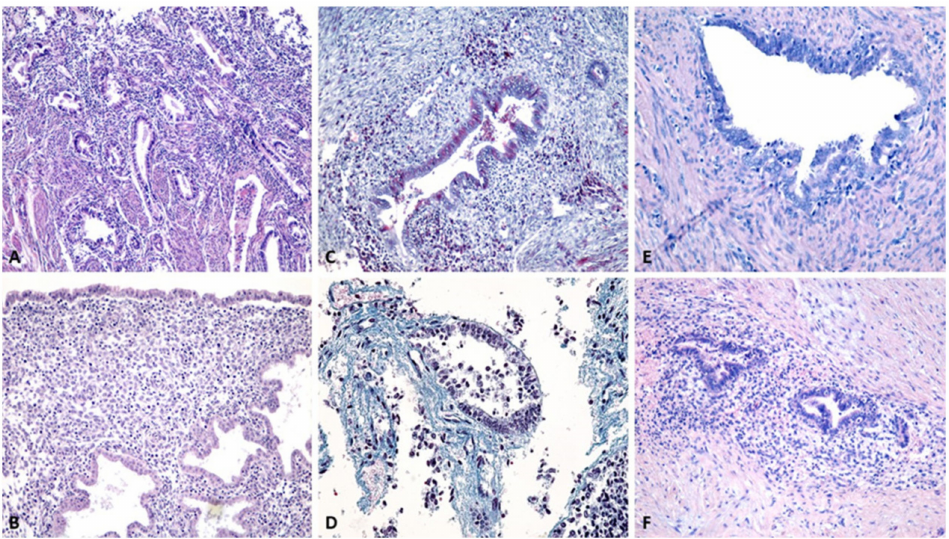
Figure 2. ( A – F ): Sections through the normal uterine lining and endometriosis samples with different locations. ( A ) Endometrial mucosa with endometrial glands in follicular or proliferative phase, around ovulation. Numerous young cells are identified in the cytogenetic chorion: fibroblasts, lymphocytes, macrophages, and endometrial glands [HE staining, × 100]; ( B ) normal endometrium in the secretory or progesterone phase. At the level of the cytogenic chorion are identified numerous young cells with round-oval shape, numerous blood vessels, and endometrial glands with many secretory cells and few hair cells; enlarged lumen of the uterine glands with the appearance of “saw teeth” [HE staining, × 100]; ( C ) ovarian endometriosis. A simple columnar epithelium is observed with the ovarian cortex’s periglandular stroma and periglandular inflammatory infiltrates [MT staining, × 100]; ( D ) peritoneal endometriosis. A simple columnar epithelium, periglandular stroma, and periglandular inflammatory infiltrate under the peritoneal mesothelium, along with typical intraperitoneal elements: loose connective tissue with adipocytes, collagen fibers, blood vessels, fibroblasts [MT staining, × 100]; ( E ) endometrial glands located in the structure of the myometrium— adenomyosis. Around the glands, stroma is almost absent, with lymphocyte cells and macrophages [HE staining, × 100]; ( F ) parietal endometriosis in the structure of the right abdominal muscle, 2 years after cesarean section. Endometrial glands with simple cylindrical epithelium and periglandular stroma are identified [HE staining, × 100]. HE: Hematoxylin-Eosin. MT: Masson’s